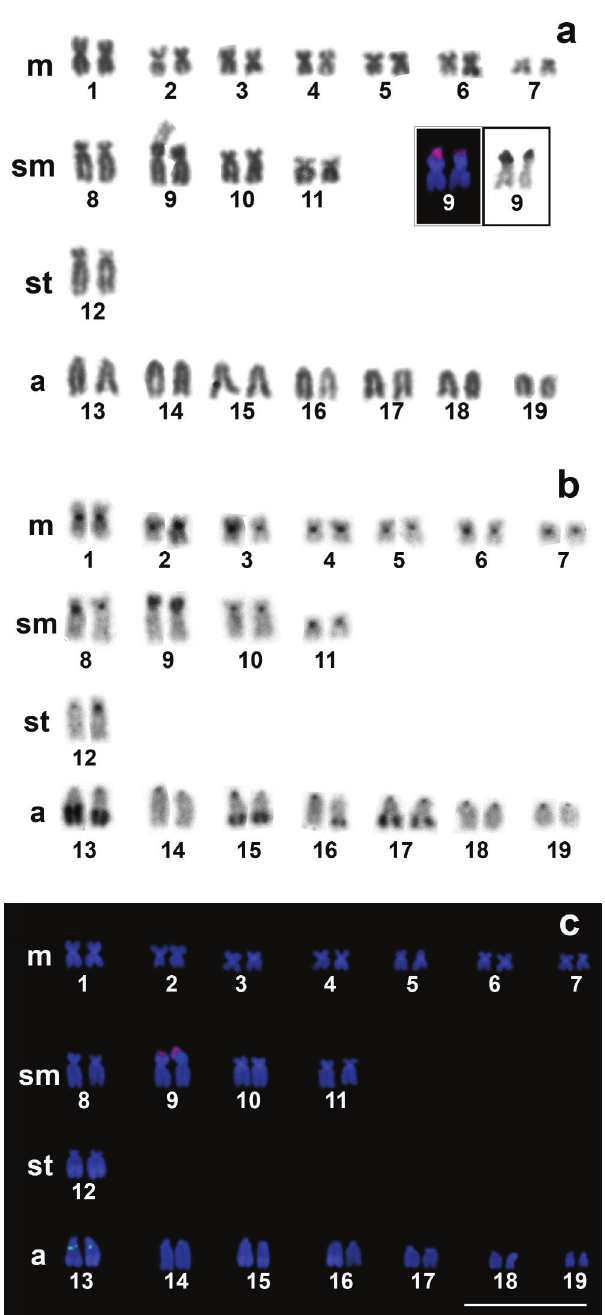
Fig. 3. Karyotypes of Gymnorhamphichthys britskii arranged a. from Giemsa stained; b. C-banded; and c. after double- FISH with 18S rDNA (red) and 5S rDNA (green) probes.. The NOR-bearing chromosomes (pair 9) are in the box. Note the size heteromorphism involving the NORs detected by the Ag- NOR and 18S rDNA-FISH techniques. Scales bar = 10